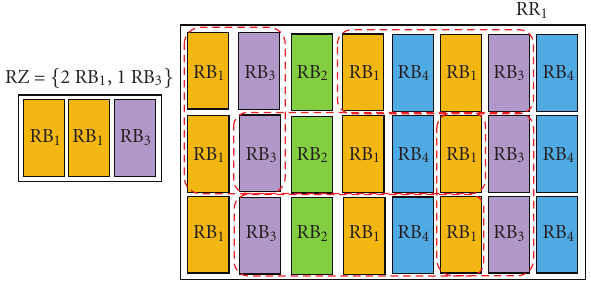
Figure 3: Example of partitioning RR 1 into